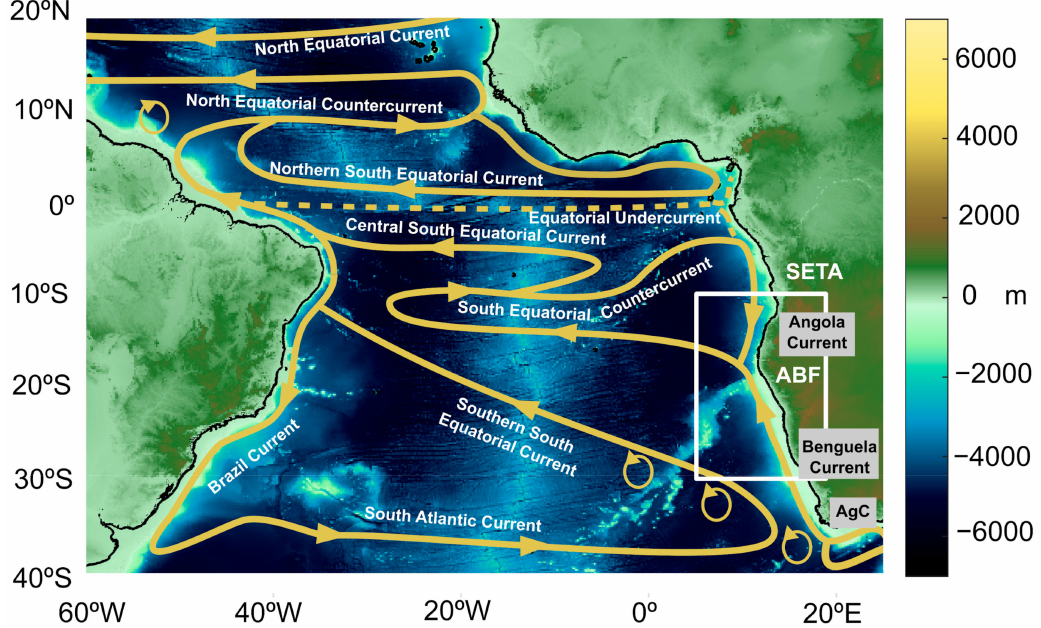
Figure 1. Bathymetry of the Tropical Atlantic in which the configurations of the main near-surface currents are depicted. AgC refers to the Agulhas Current. In this figure, the Southeastern Tropical Atlantic (SETA) and Angola–Benguela Front (ABF) regions are also